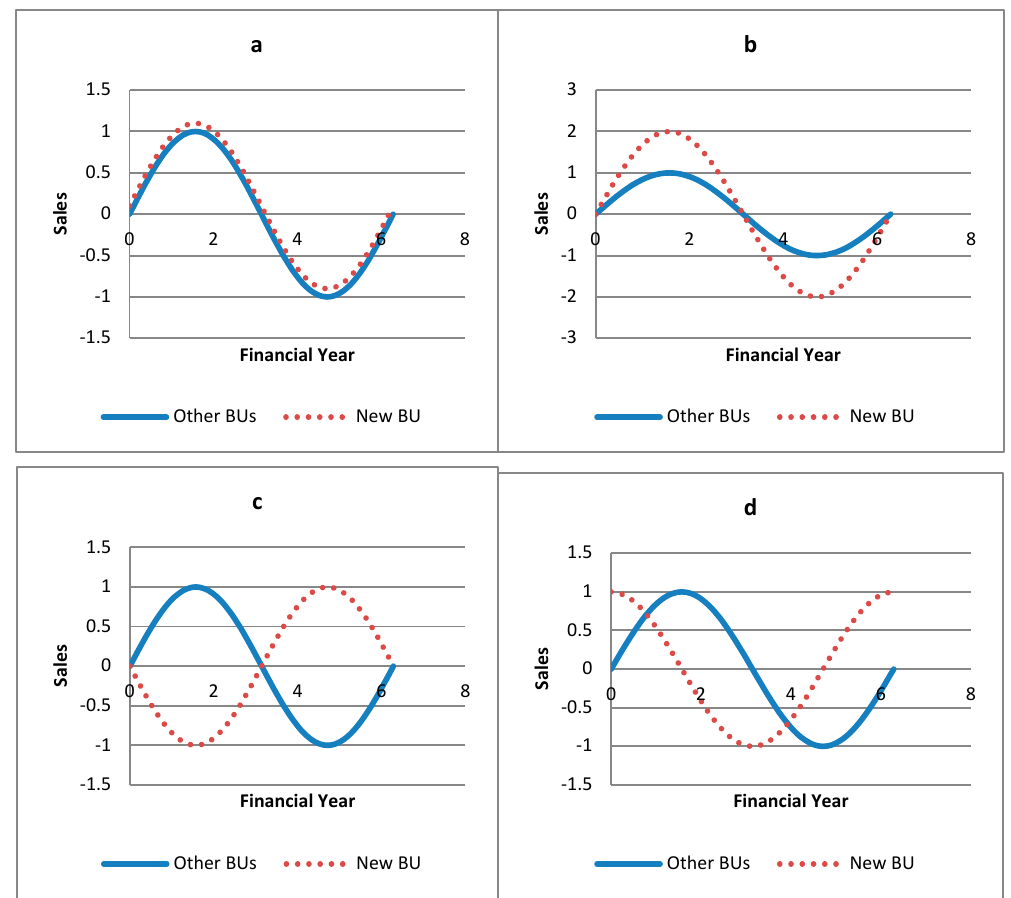
Figure 1. Business Units’ Movements and Desynchronicity.